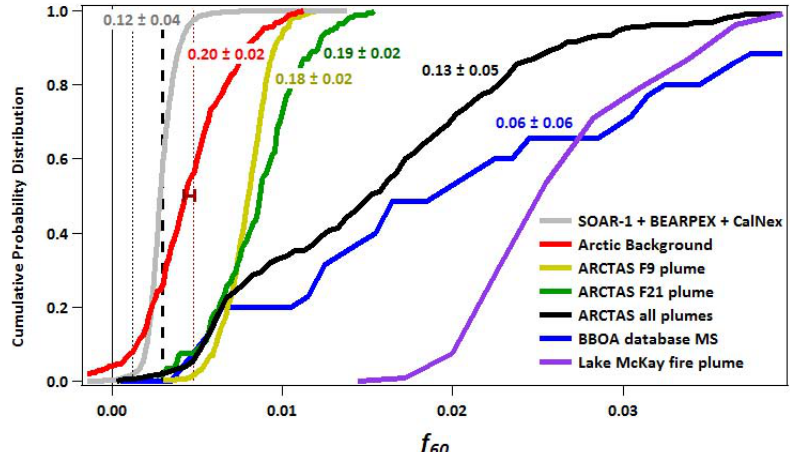
Fig. 6. Cumulative probability distributions of f 60 from multiple datasets. The nominal background value at 0.3% is shown by the thick dashed line, and the 3-sigma widths of the negligible-BB datasets by the thin dashed lines. The mean ± standard error for the “Arctic- background” dataset are indicated by the horizontal red bar. The mean and standard deviation of the f 44 value for each dataset is indicated on the